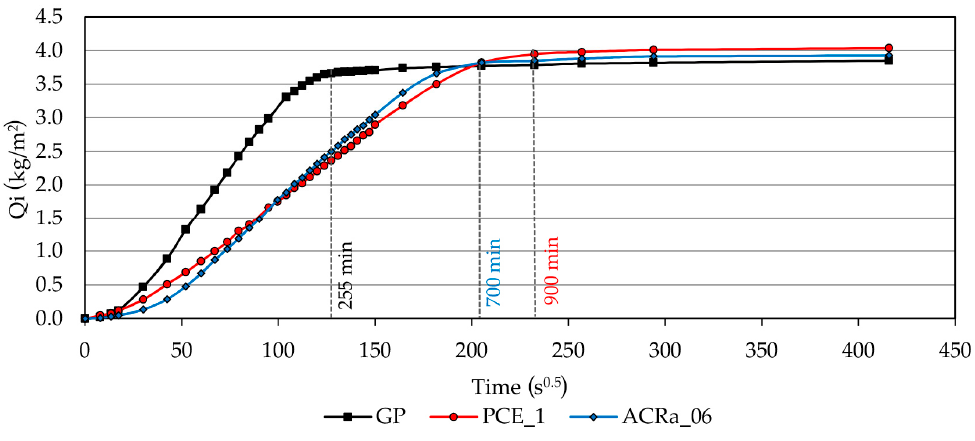
Figure 8. Capillary water absorption test results for GP, PCE_1, and ACRa_06 samples. The time of saturation for each sample is indicated with a vertical line.